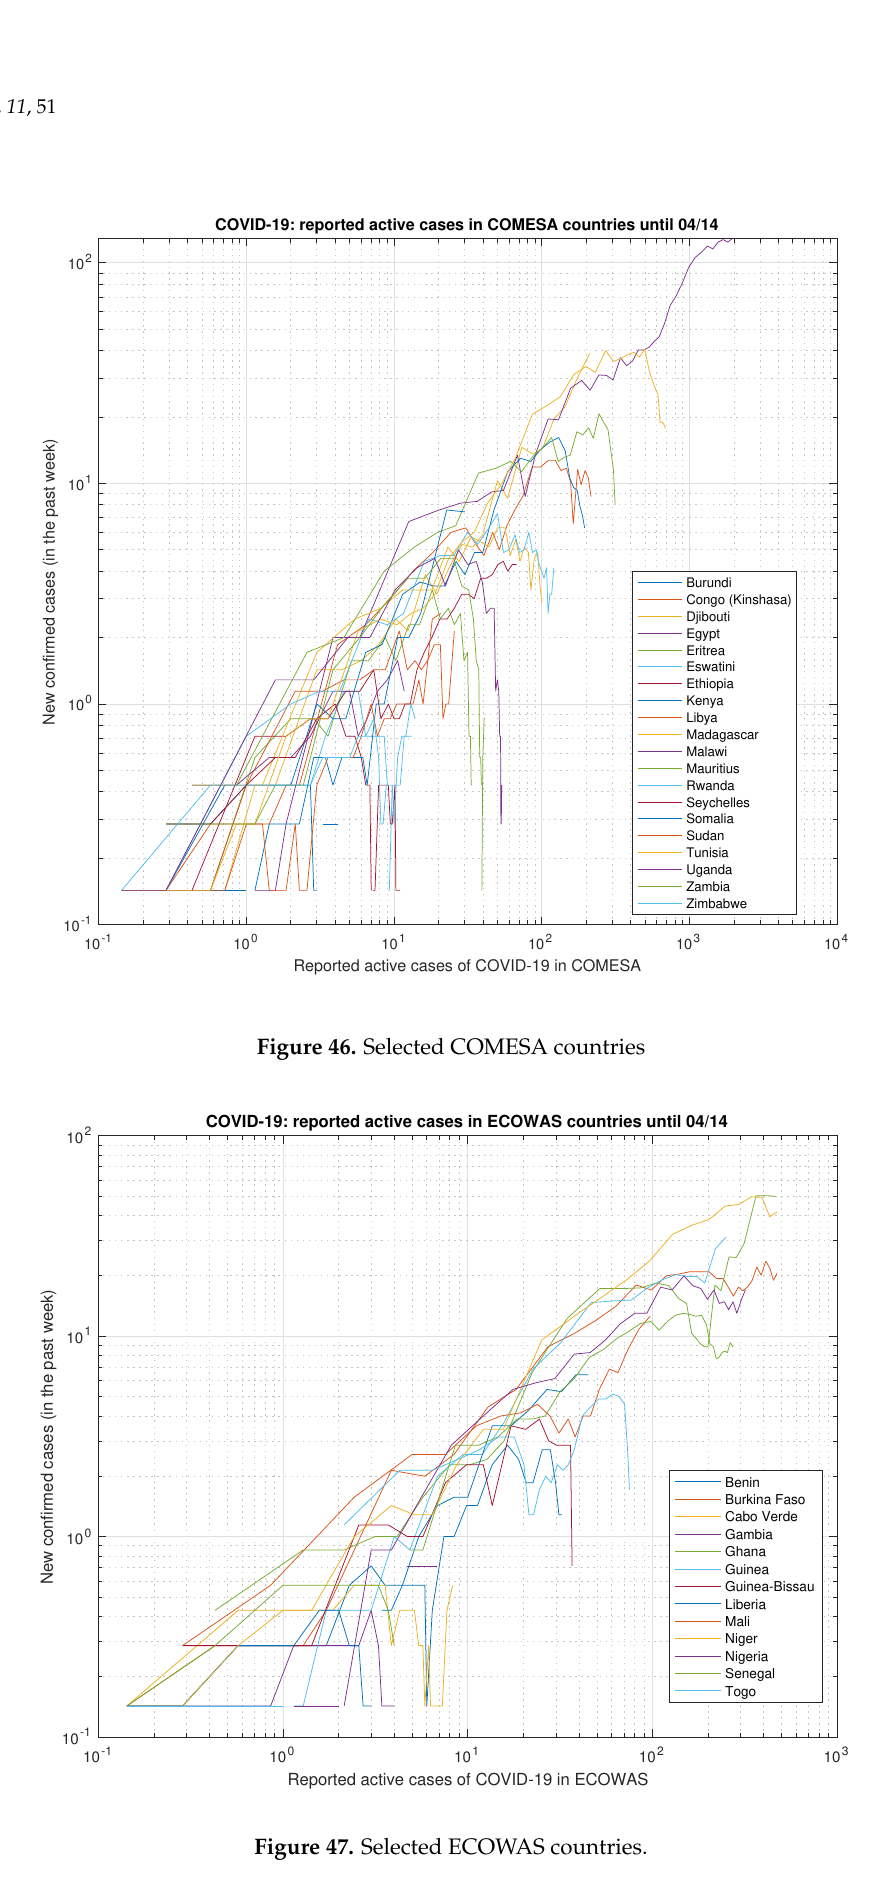
Figure 47. Selected ECOWAS